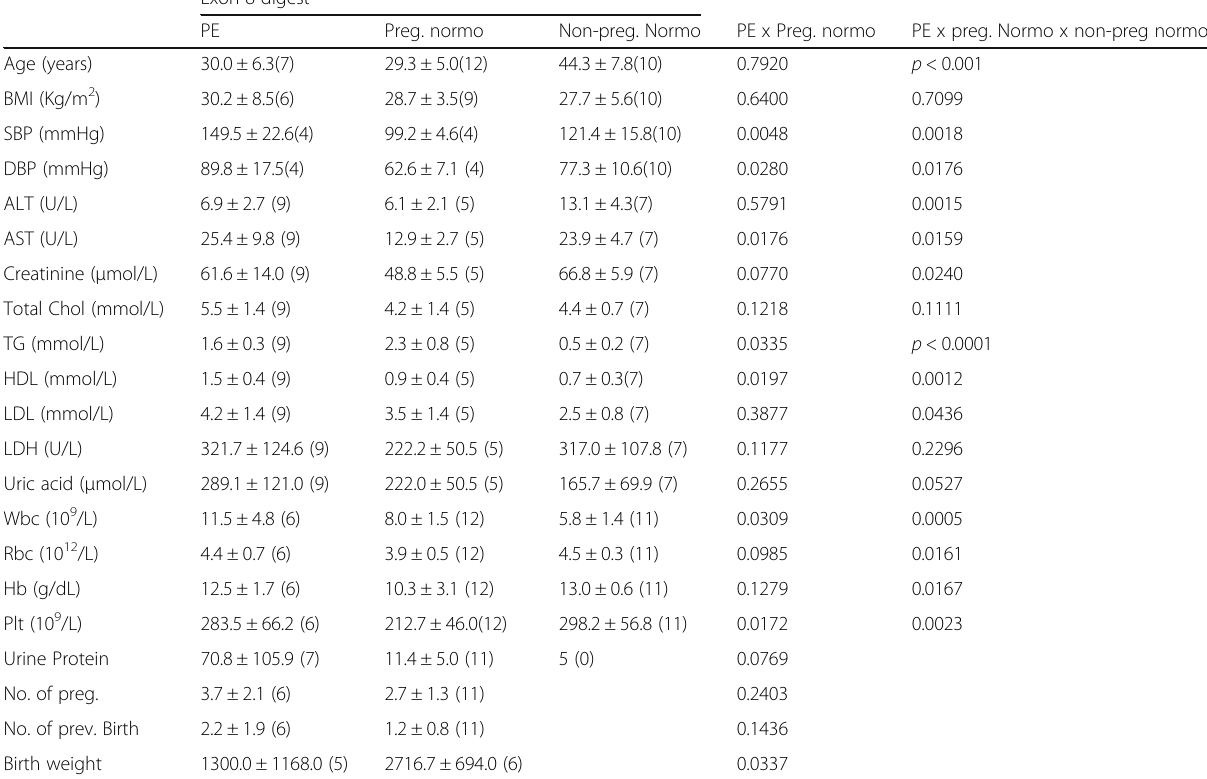
Table 3 Exon 8 FVL stratification with clinical